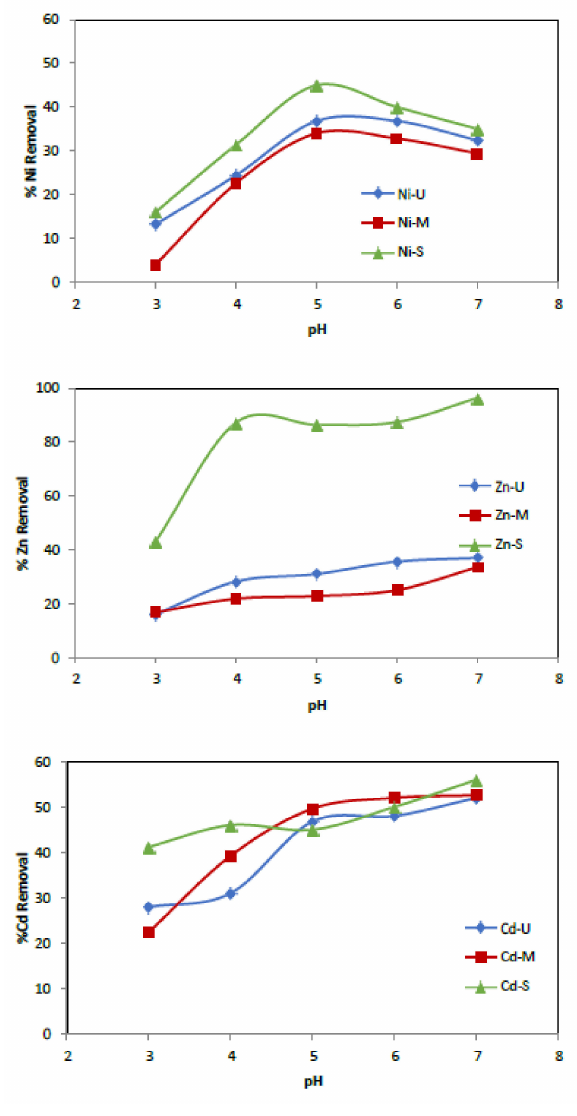
Figure 9. Metals’ removal onto waste toner powder versus initial pH. (Co = 50 mg/L, adsorbent = 0.25 g, t = 24